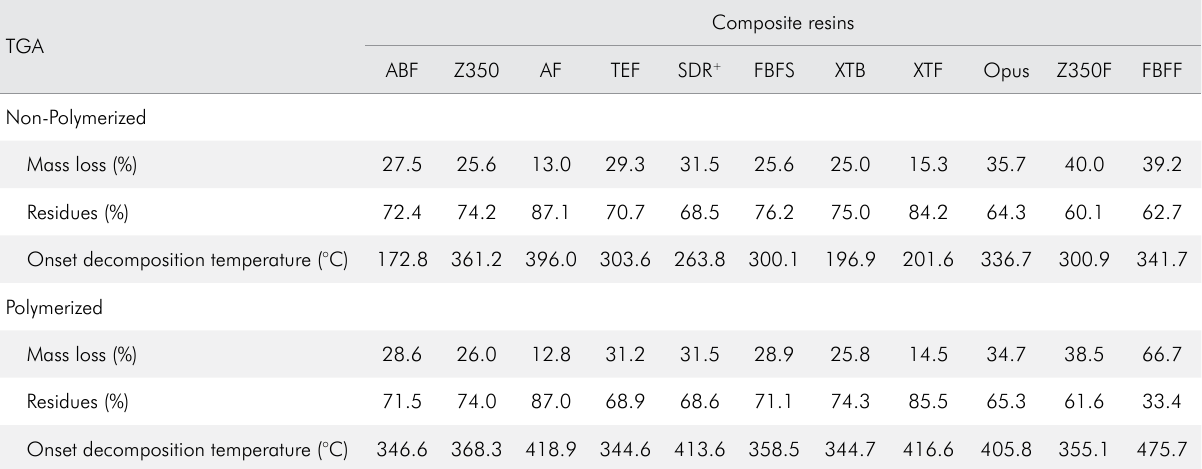
Table 3. Mean values of mass loss (%), residues (%), and onset decomposition temperature of each resin – TGA.